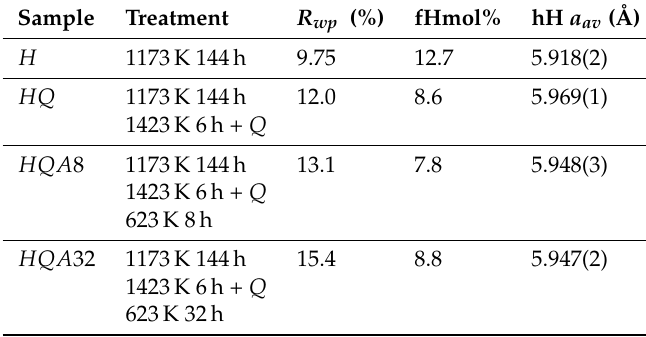
Table 1. Heat treatments for each sample are given. Values for goodness of fit ( R wp ), mole percent of the full-Heusler phase and the weighted average lattice parameter of the half-Heusler phases (hH a av ) with Ni interstitials are determined from the Rietveld refinement of synchrotron XRD